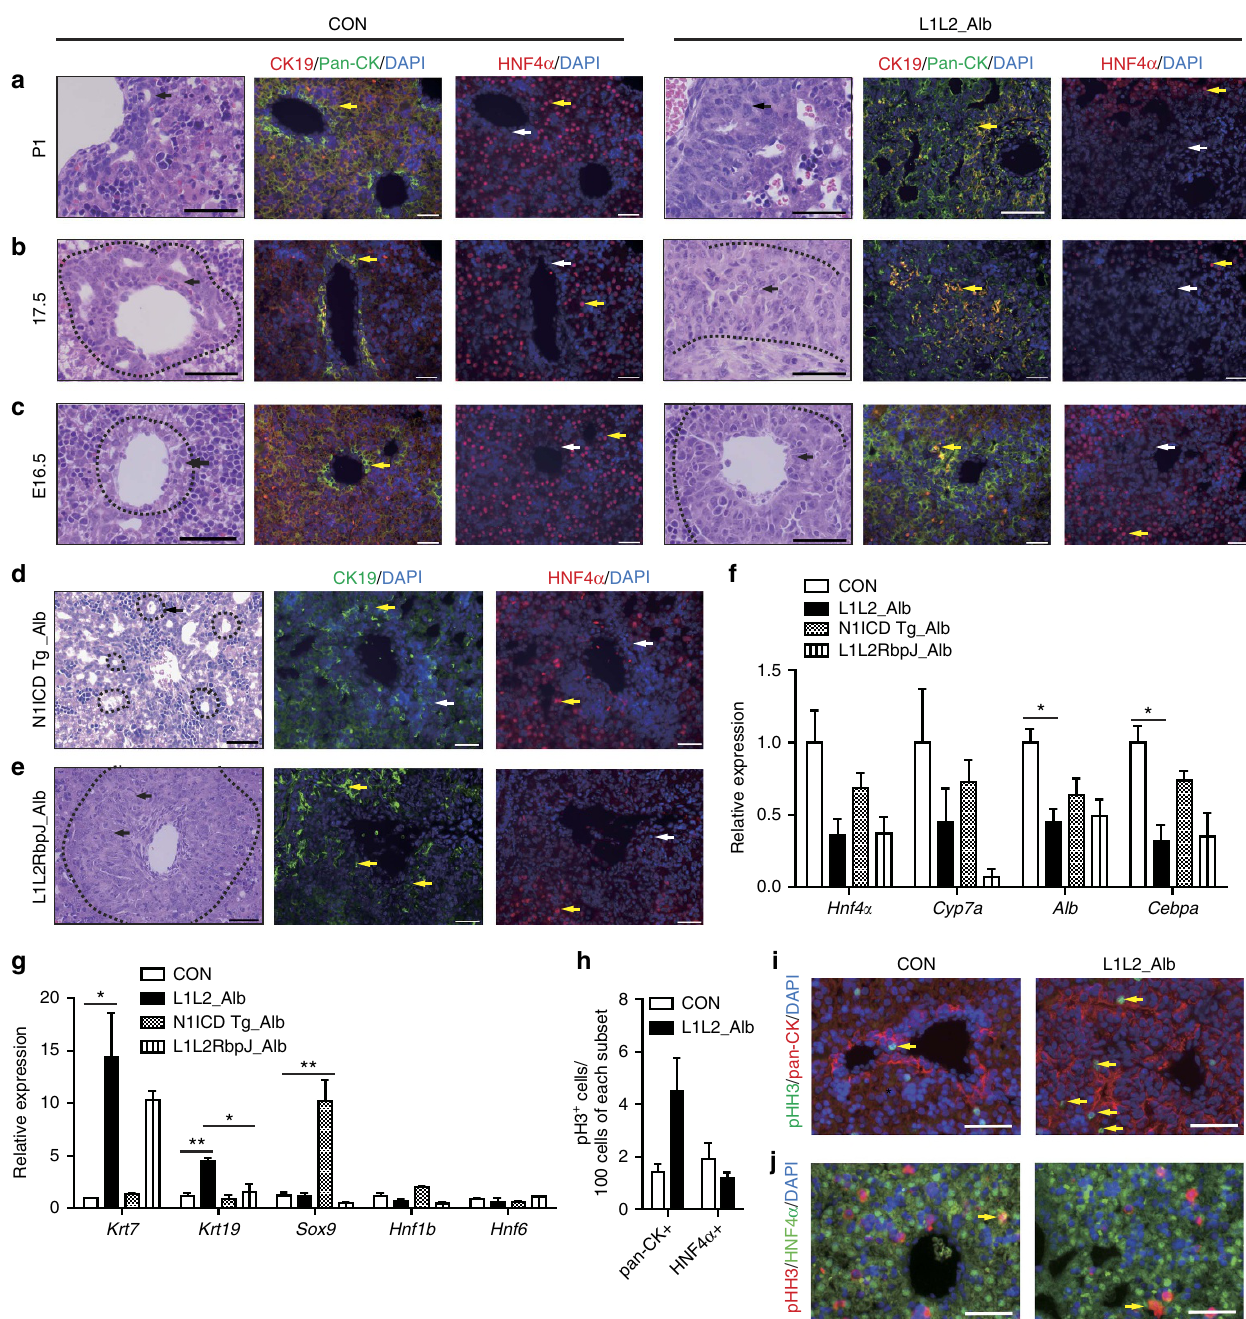
Figure 2 | Loss of Lats1 and Lats2 in embryonic livers causes abnormal liver development. ( a – c ) Haematoxylin and eosin (H&E) staining (first and fourth column), immunofluorescence staining with anti-CK19, anti-pan-CK and diamidino-2-phenylindole (DAPI; second and fifth column), and anti-HNF4 a and DAPI (third and sixth column) of control and L1L2_Alb livers at postnatal day (P) 1 ( a ), embryonic day (E) E17.5 ( b ) and E16.5 ( c ). Black arrows indicate ductal plate cells, and the dotted lines indicate ductal plates. Yellow arrows indicate positive antibody signal; white arrows indicate a lack of staining. Scale bars, 50 m m. ( d , e ) Representative H&E (left), immunofluorescence staining with anti-CK19 and DAPI (middle) and anti-HNF4 a and DAPI (right) result of N1ICD Tg_Alb livers ( d ) and L1L2RbpJ_Alb livers ( e ) at P1. Black arrows indicate ductal plate cells, and dotted lines indicate bile ducts. Yellow arrows indicate positive antibody signal; white arrows indicate a lack of staining. Scale bars, 50 m m. ( f , g ) Relative mRNA expression levels of hepatocyte-related genes ( f ) and BEC-related genes ( g ) obtained from P1 livers of the indicated genotypes, as assessed by qRT-PCR. ( h ) The number of pHH3 (S10)-positive cells out of 100 pan-CK- and HNF4 a -expressing cells in P1 control and L1L2_Alb livers. ( i , j ) Representative immunohistochemical staining results obtained using antibodies against phospho-Histone H3 (S10) and –pan-CK ( i ) or -HNF4 a ( j ) of control and L1L2_alb livers at P1. Yellow arrows indicate double positive signal. Scale bars, 100 m m. The data are presented as means ± s.e.m.; n ¼ 3, * P o 0.05 and ** P o 0.01 (Student’s t phosphorylated YAP (S127). In control, embryonic liver obtained ducts after birth), while phosphorylated YAP (S127) was localized at E16.5, YAP was found to be localized in nuclei of the cells that to the cytoplasm of ductal plate cells and observed more sparsely made up the ductal plate (which give rise to intrahepatic bile in the cytoplasm of all cells throughout the liver (Fig. 3a and